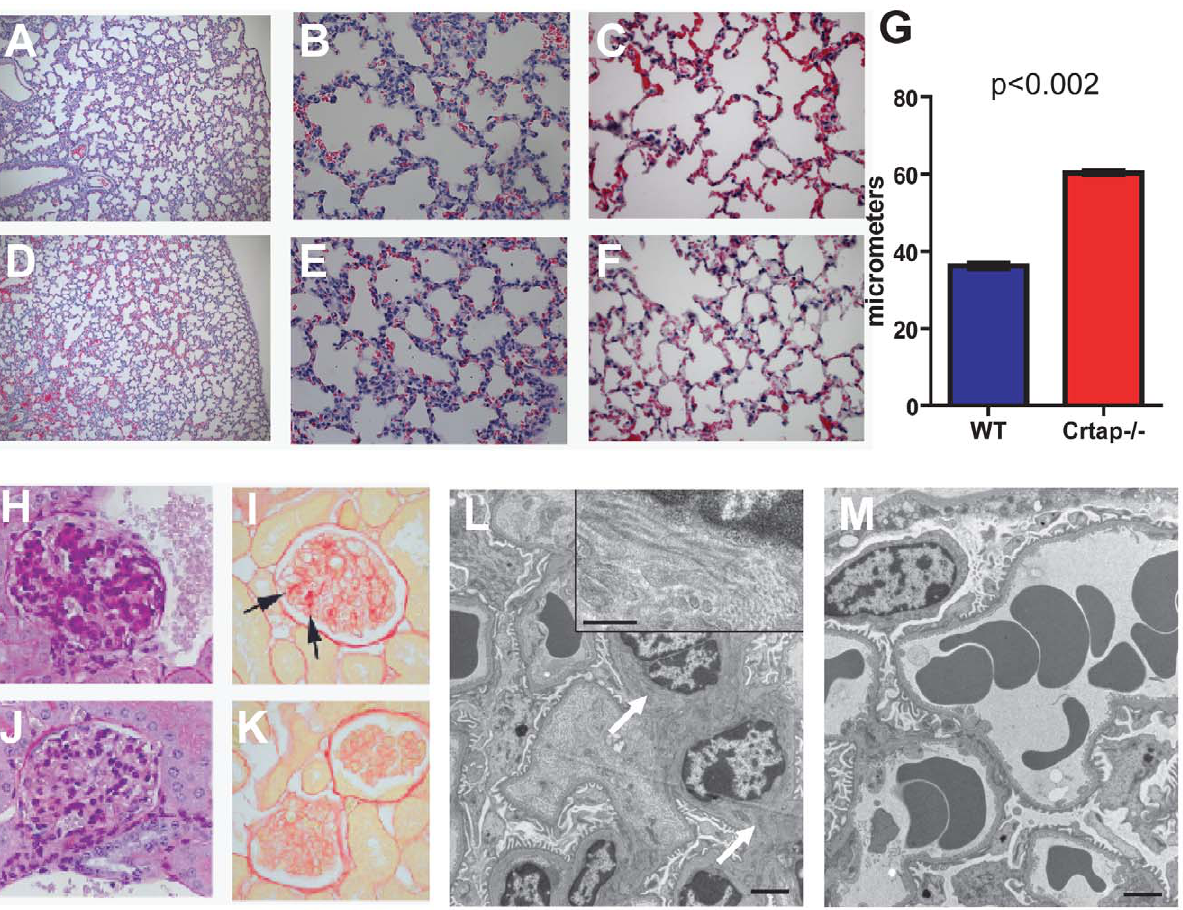
Figure 2. Lung and kidney abnormalities in Crtap-/- mice. Mutant lung H&E stained sections at P10, at 10 6 magnification ( A ) and 40 6 magnification ( B ), and in the adult at 40 6 magnification ( C ). Wildtype lung H&E stained sections at P10, at 10 6 magnification ( D ) and 40 6 magnification ( E ), and in the adult at 40 6 magnification ( F ). ( G ) Quantification of alveolar airway space by Mean Linear Intercept (MLI) shows increased airway space in Crtap-/- mouse lungs. Mutant adult kidney stained sections shows that some glomeruli have abnormal staining by PAS ( H ) and picrosirius red ( I ) at 40 6 magnification, suggestive of focal glomerulosclerosis. These changes were never observed in corresponding wildtype sections ( J–K ). Transmission EM images of Crtap-/- and WT glomeruli ( L–M , scale bar =2 m m) showing mesangial hyperplasia and abnormal collagen fibril deposition in the mutant (arrows and inset, scale bar in inset is 0.5 m m).